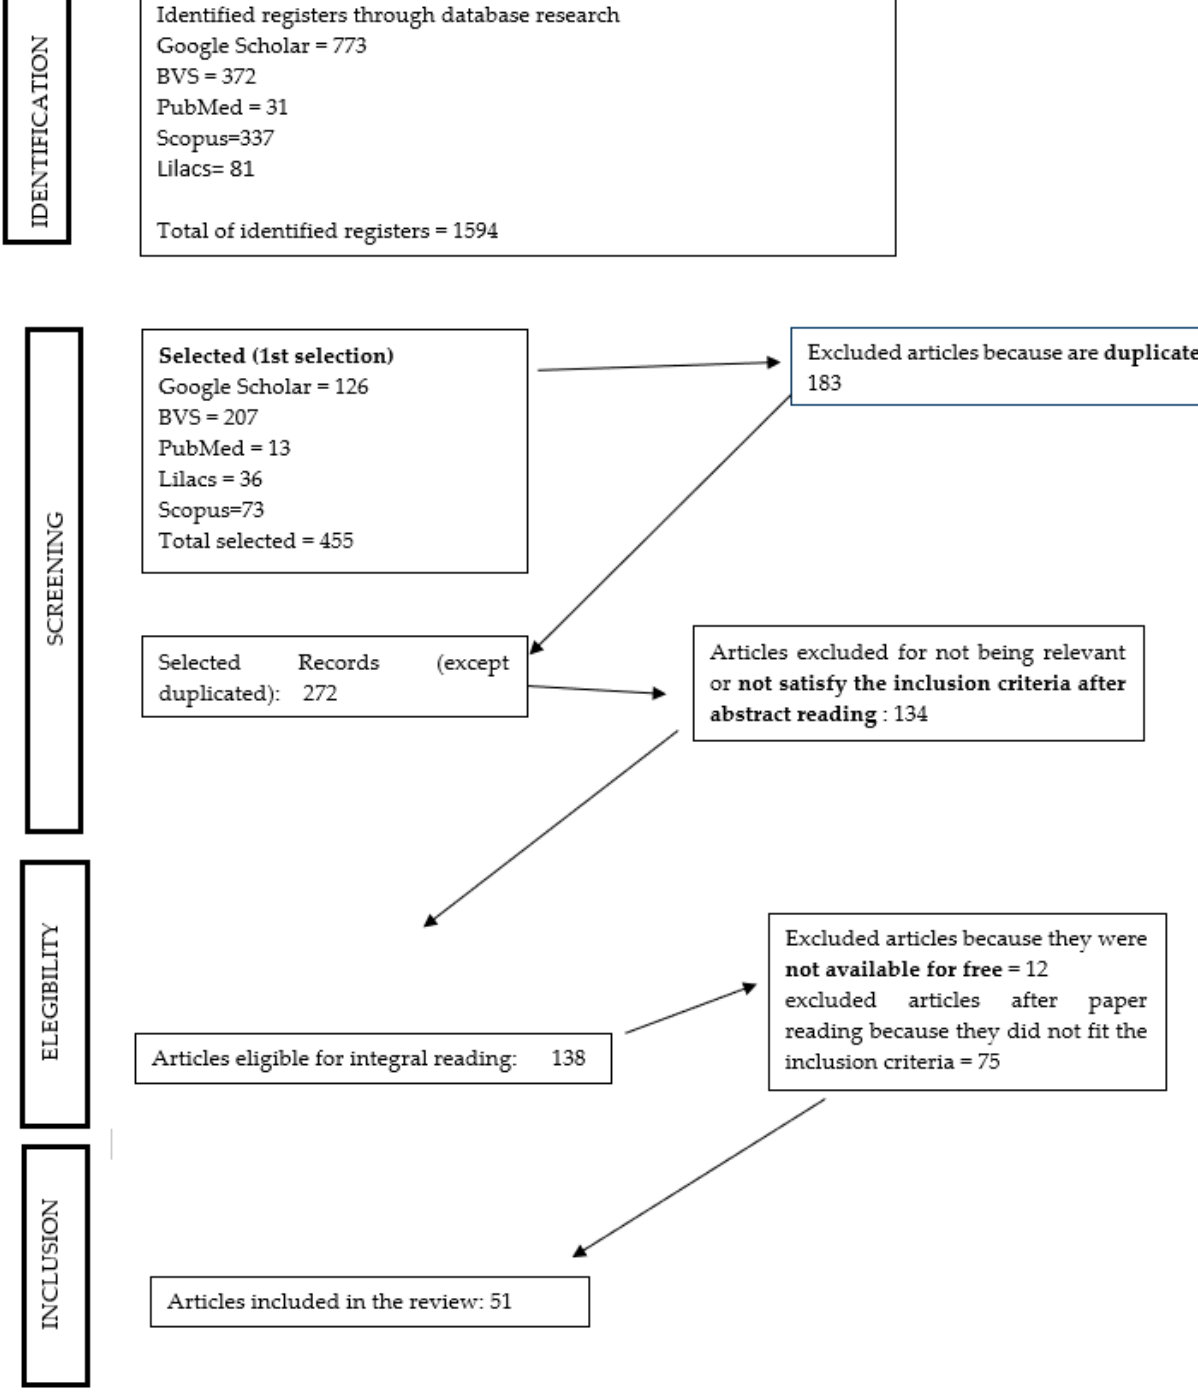
Figure 1. Article selection in the PRISMA review process.